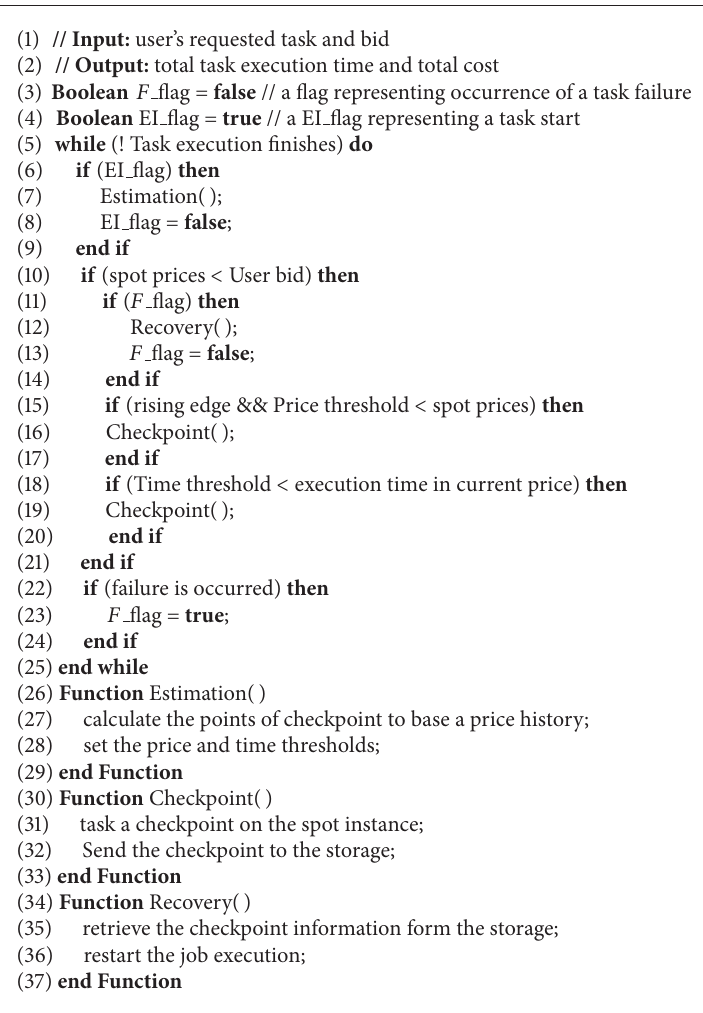
Algorithm 1: Checkpointing and recovery algorithm.